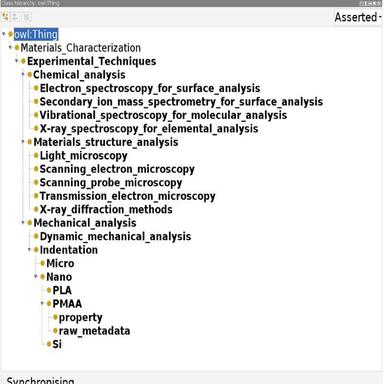
Ontology class hierarchy.